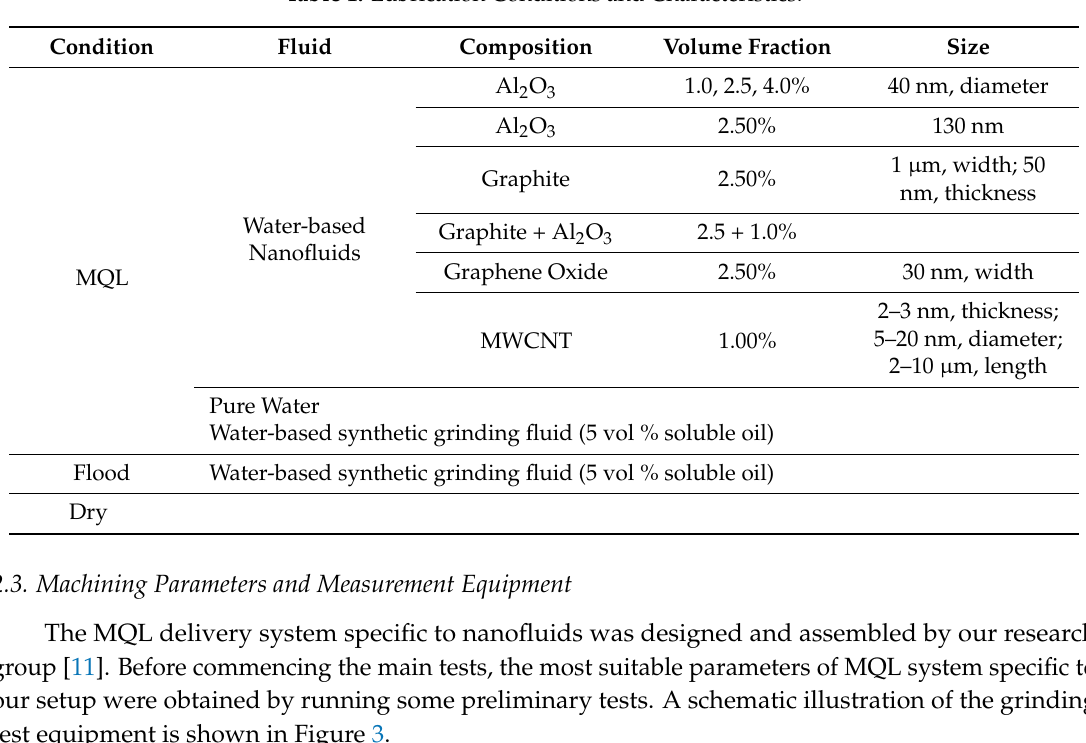
Figure 3. Grinding experiments diagram.